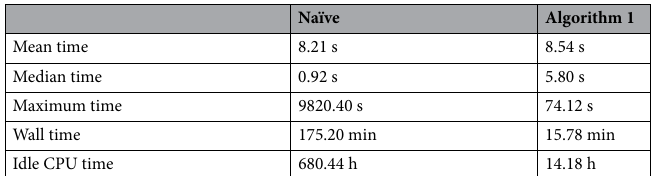
Table 2. Parallelization computation improvements. We can significantly reduce the wall time required when enumerating subgraphs over a compute cluster by relabeling the vertex indices, as described later in the “Methods”. We reduced the maximum time for enumerating from a root vertex from just under three hours to slightly more than 1 min on the Drosophila dataset. The new enumeration order reduces the idle CPU time by over 665 h (97.9% decrease). The distribution of individual times for the naïve method is highly skewed to the right; 5% of nodes account for over 62% of computation time.